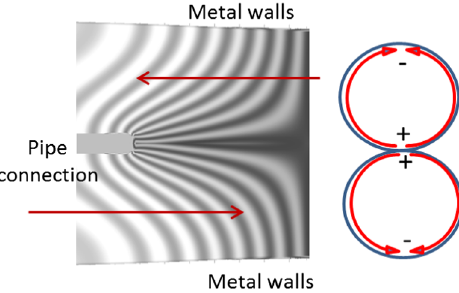
FIG. 3. Electric field line distribution (left plot) and surface current distribution (right plot) of the trapped mode. Each surface current plane has a longitudinal slope of the corresponding sign. The red lines show the direction of the colliding beams.